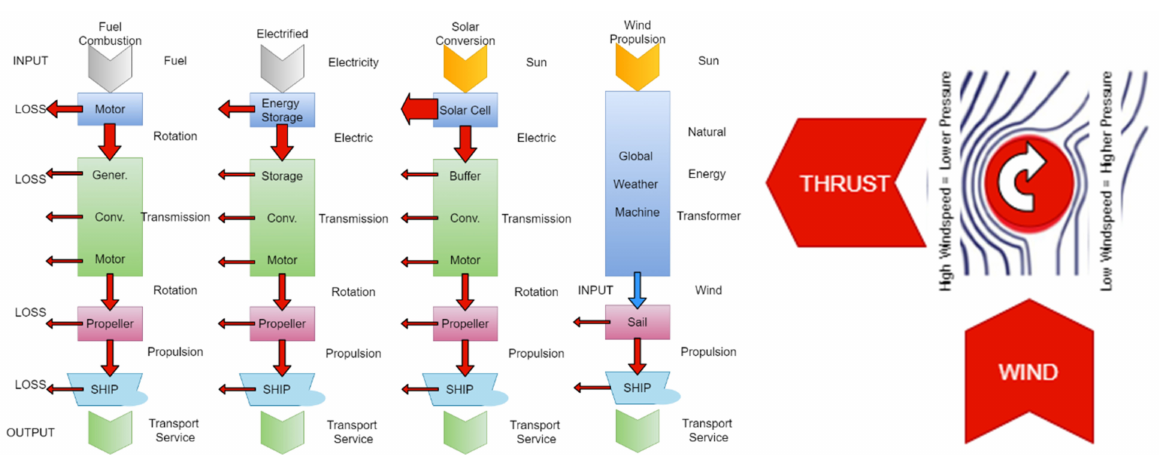
Figure 8. Modes of Energy Transformation for Ocean Transport and the Magnus Effect used by the Flettner rotors adapted from